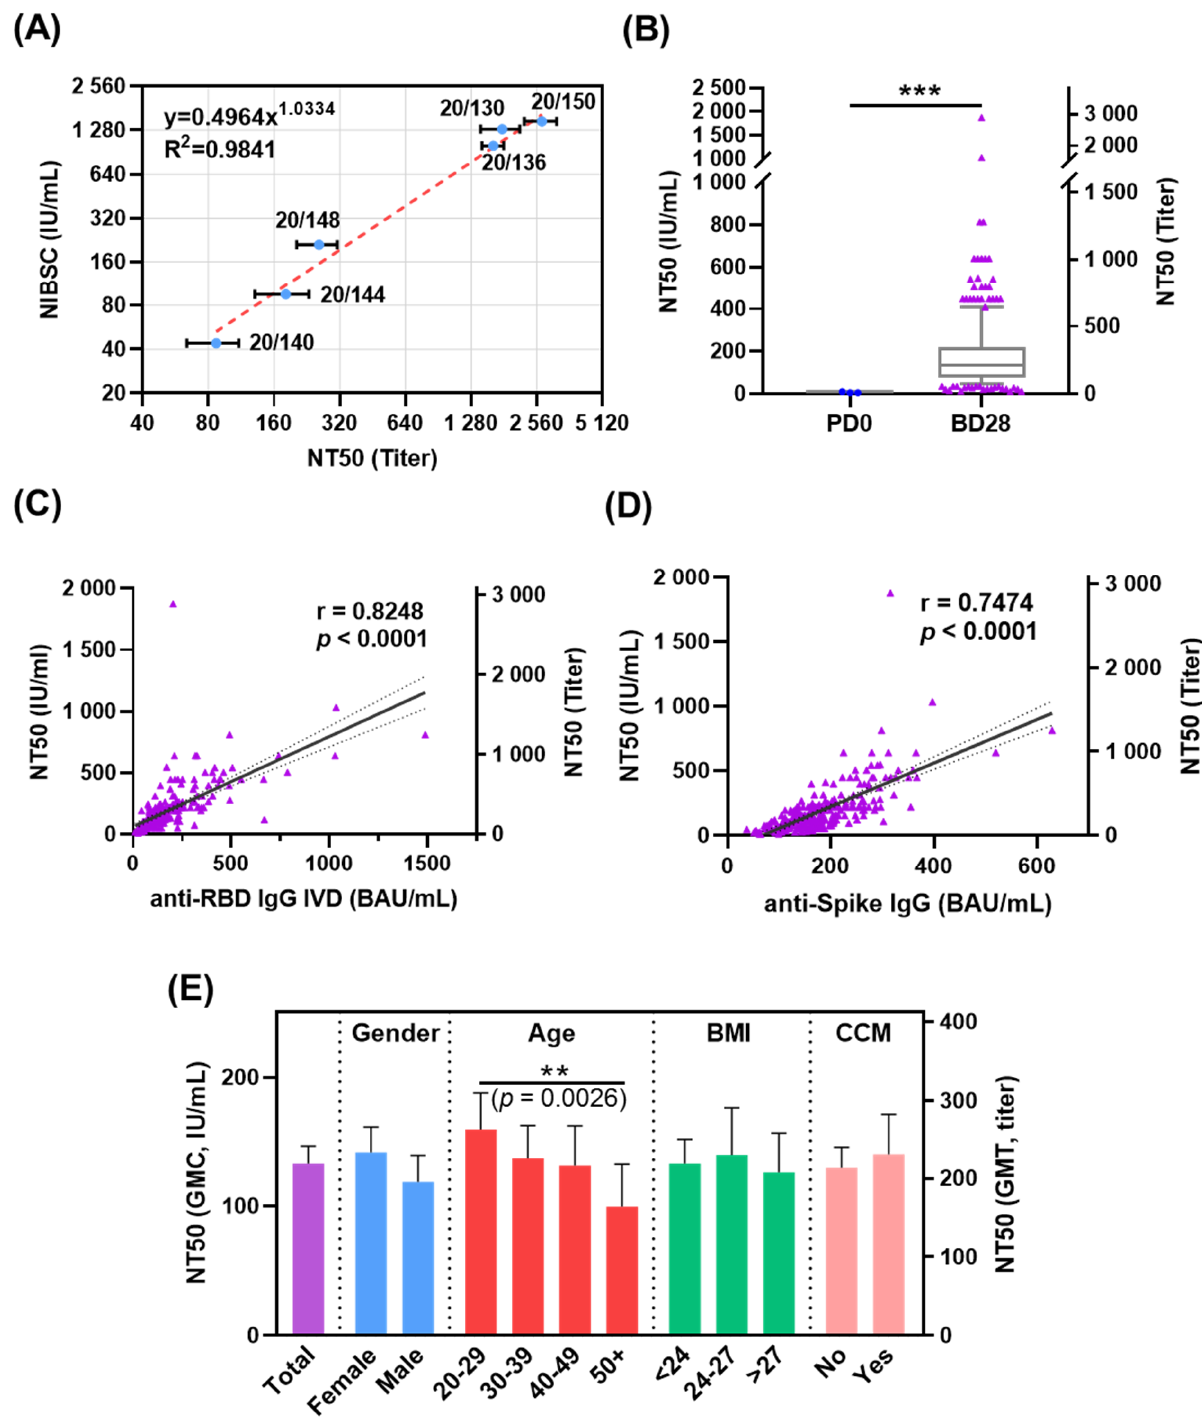
Figure 2. Neutralizing activity of vaccine-elicited antibody. ( A ) Neutralizing antibody titer (NT50) of NIBSC standards was measured by SARS-CoV-2 live virus neutralization assay. ( B ) NT50 of serum samples collected from participants at PD0 and BD28. ( C , D ) Linear regression analyses showed the correlation of NT50 against anti-spike RBD ( C ) or anti-spike IgG ( D ). ( E ) The GMCs or GMTs and 95% CI of NT50 against SARS-CoV-2 in subgroups. ** p < 0.01; *** p < 0.001.